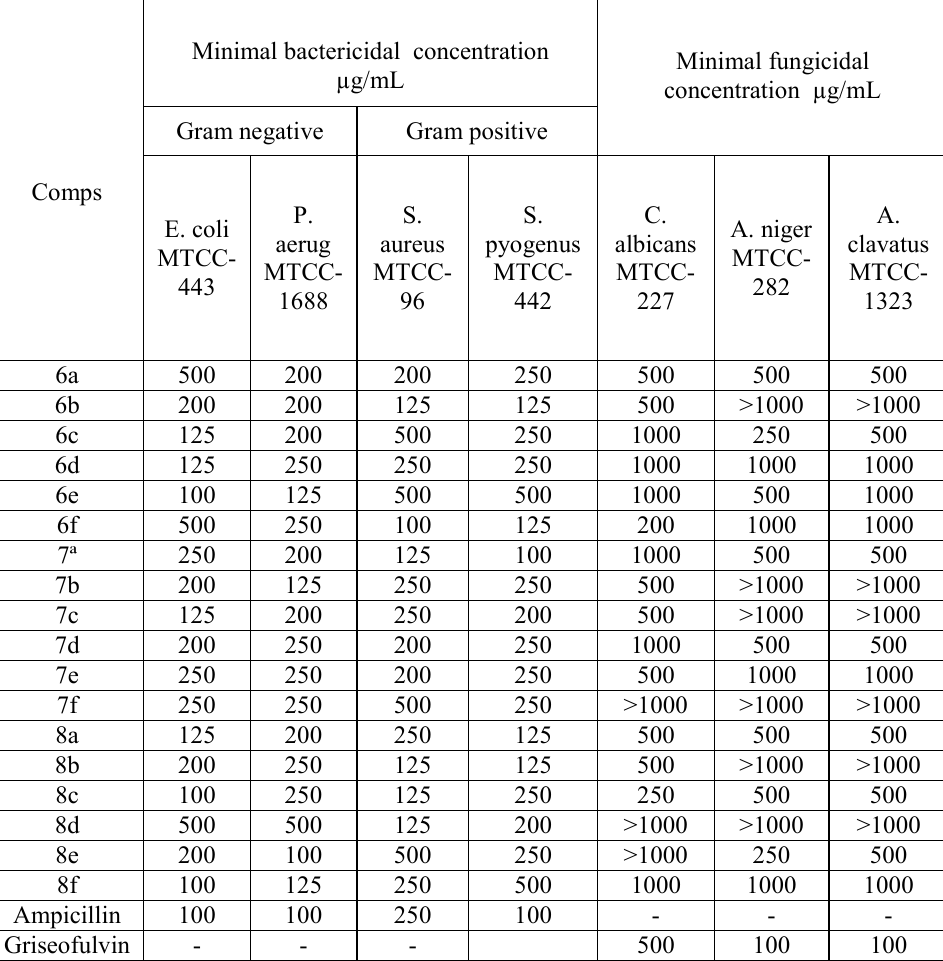
Table 2. Antibacterial and antifungal activity data of compounds 6(a-f), 7(a-f) and 8(a-f).